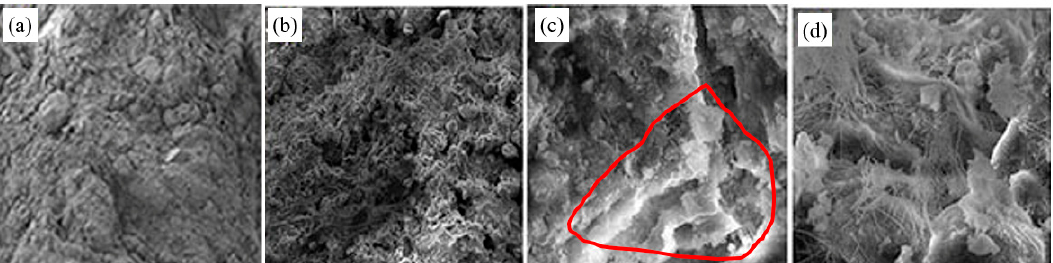
Figure 8. The microstructure of the recycled aggregates with scanning electron microscopy (SEM): ( a ) recycled brick aggregates, ( b ) recycled concrete aggregates, ( c ) dry-mixing aggregates with MSi, and ( d ) dry-mixing aggregates with MSi and then slurry coating in CS.